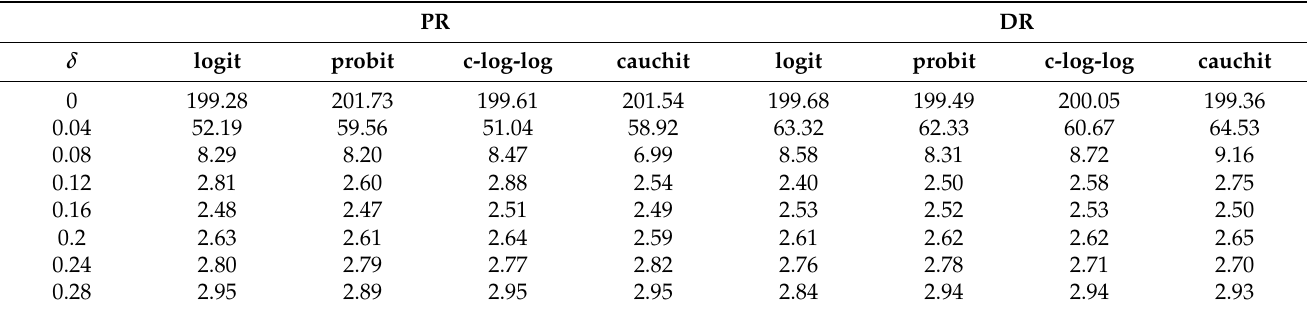
Table 4. Performance of ARL 0 = 200 with shift in µ x under considered link functions. PR